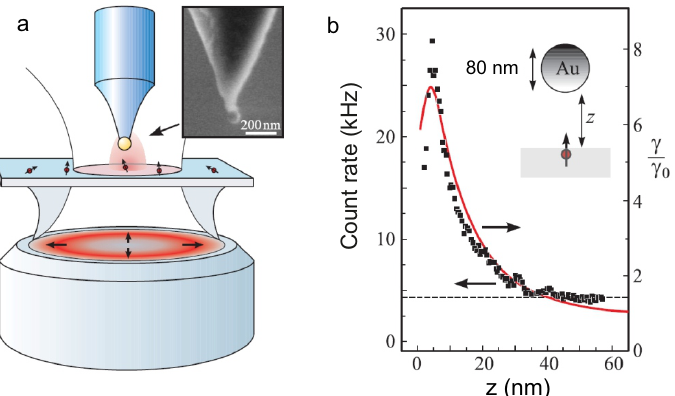
Figure 3. The influence of a gold NP placed at the end of a scanning microscope tip on the fluorescence of an individual Nile blue dye molecule: ( a ) schematic of the experimental setup, ( b ) experimental (dots) and theoretical (solid curves) dependences of the fluorescence intensity on the distance between the nanoantenna and the dye molecule. Adapted with permission from [82]. ©2021 American Physical